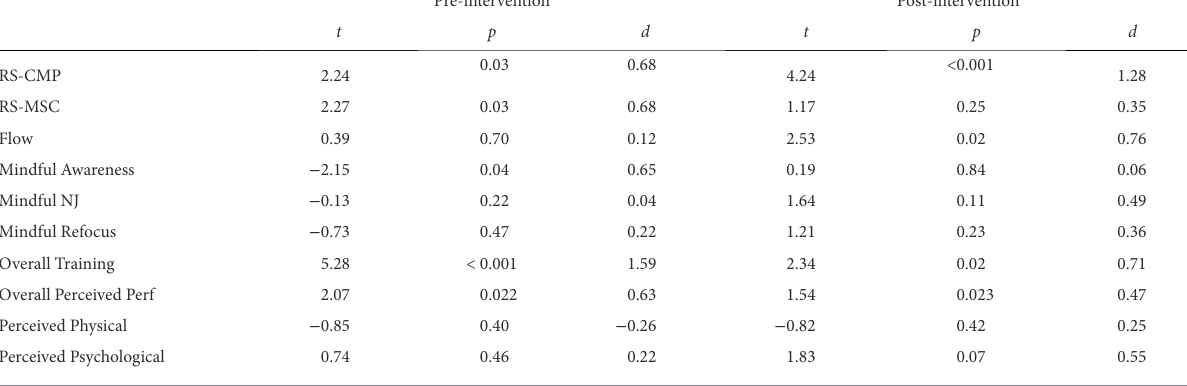
Table 1 Difference between the groups at pre- and